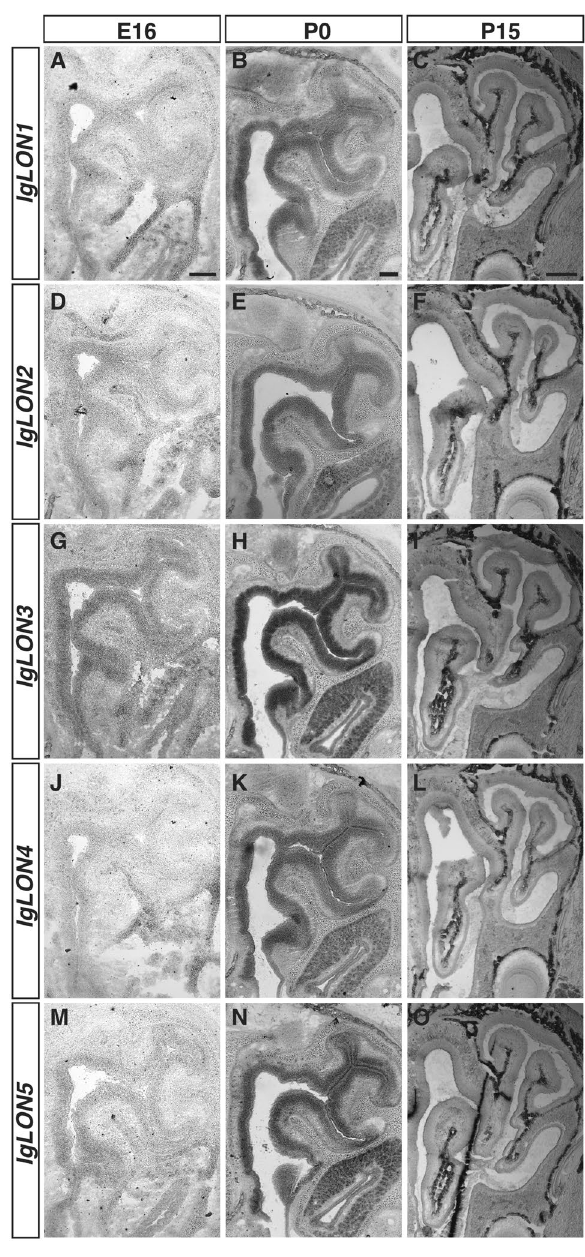
Figure 2. IgLONs mRNA expression in the developing olfactory epithelium (OE). In situ hybridization of coronal sections of OE from E16, P0, and 15 mice with antisense cRNA probes for IgLON transcripts. IgLON3 mRNA is detected in the OE at E16 ( G ), while other IgLON family members could not be detected in the OE at that age ( A , D , J , M ). By P0 all IgLONs are expressed throughout the OE ( B , E , H , K , N ) but their expression is downregulated by P15 ( C , F , I , L , O ). Scale bars = 200 µm ( A , B , D , E , G , H , J , K , M , N ) and 500 µm ( C , F , I , L , O